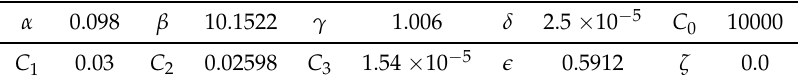
Table 2. Powertrain model coefficients for Tesla Semi